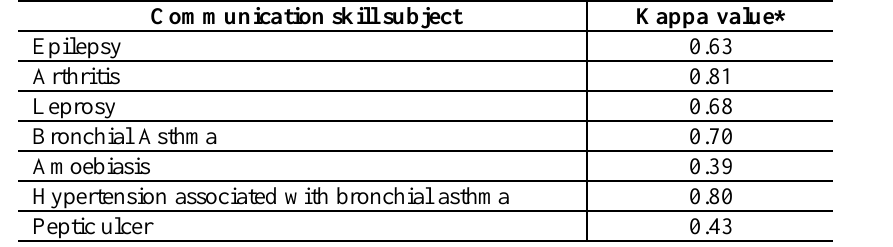
Table II : Agreement between the two observers regarding 'drug-related' factors